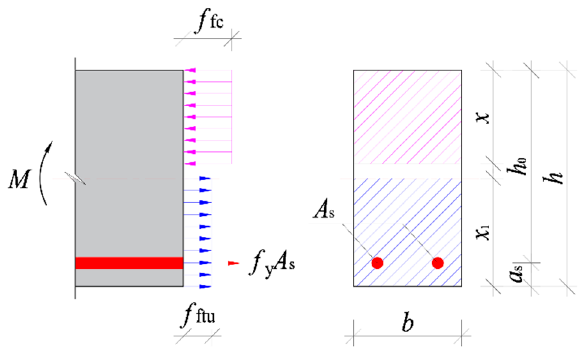
Figure 16. Numerical diagram of the ultimate moment at the cross-section.